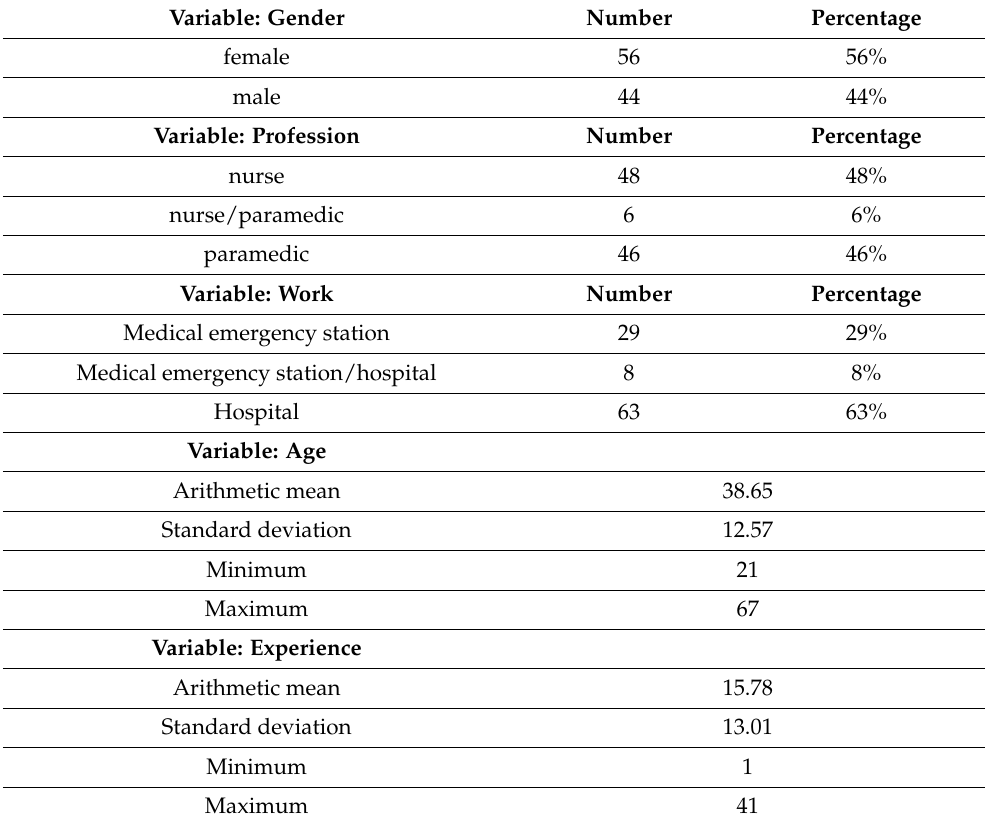
Table 1. Research group